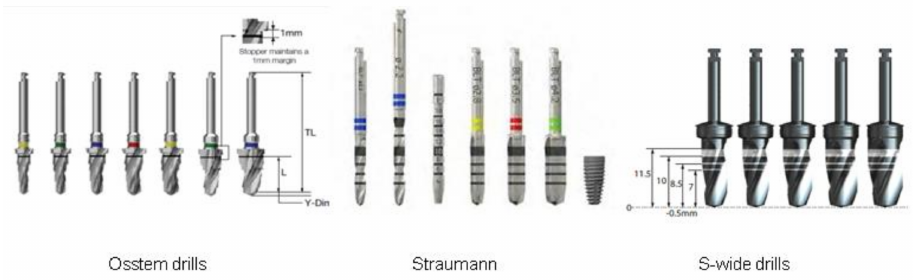
Figure 1. The drills used in the